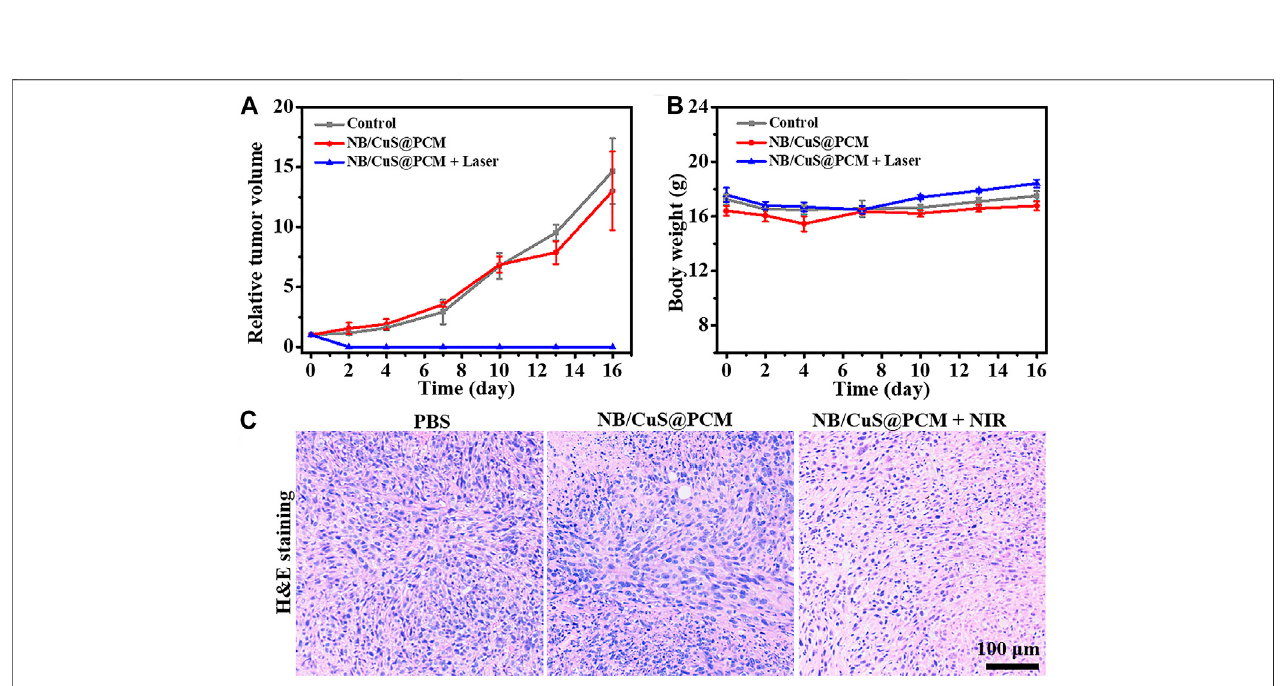
Frontiers in Bioengineering and Biotechnology |